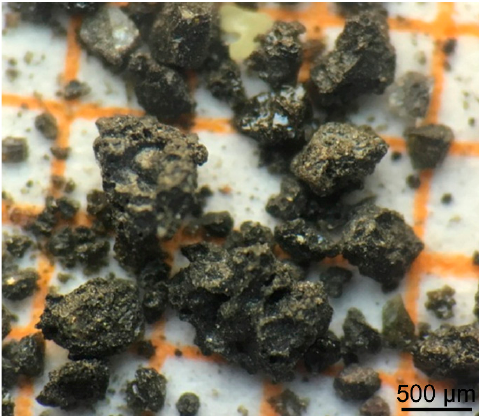
Figure 1. Optical image of ash from the 2001 Etna eruption.